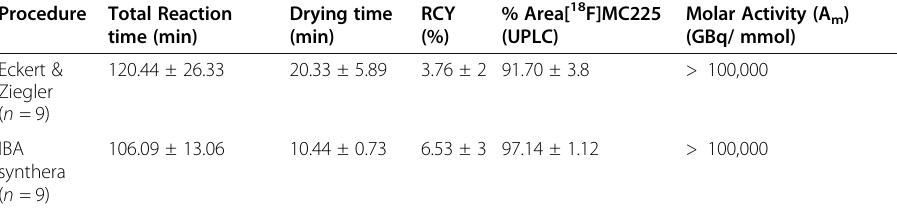
Table 1 Characteristics of the 1-step synthesis performed in Eckert & Ziegler and IBA Synthera. Values reported in mean ± SD